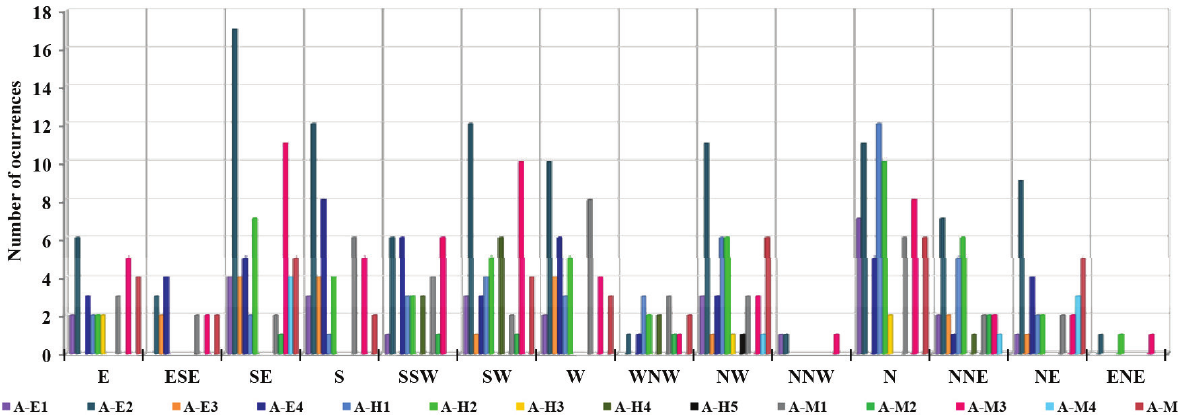
Fig. 5. Occurrence of each anomaly according to the façade orientation, within the